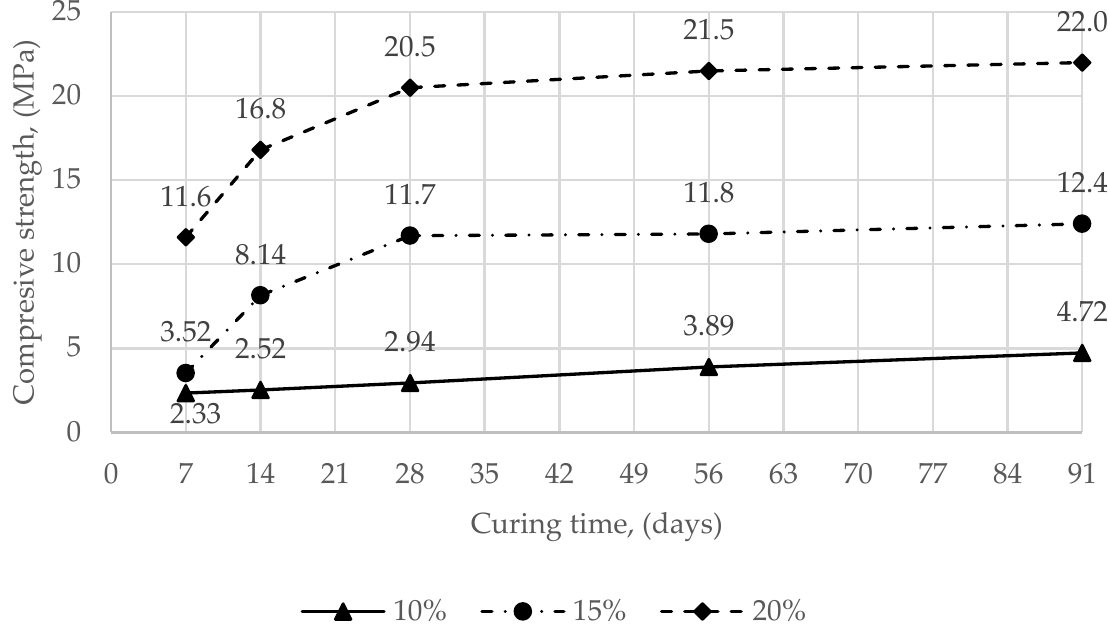
Figure 2. Compressive strength (samples of SCS with sandy soil and 10%, 15%, 20% Carbofill E binder) development with time.